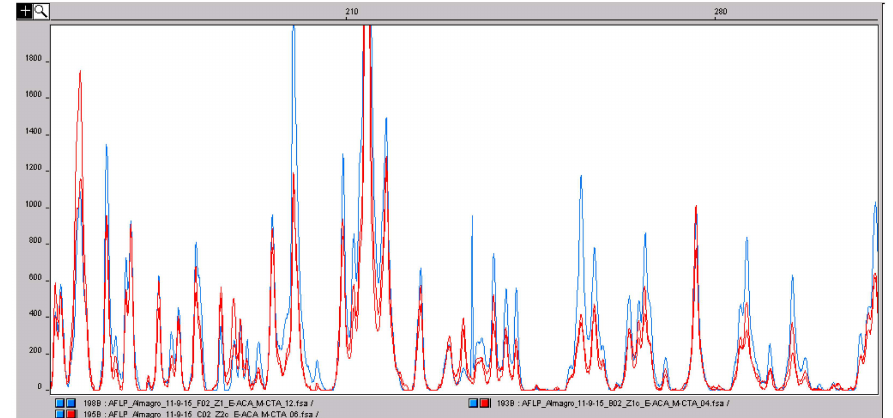
Figure 5. Comparison of the amplified fragment length polymorphism (AFLP) profile of saffron stigmas (blue) and two saffron powder samples (red). The peaks correspond to DNA fragments with a defined size in base pairs. The three profiles are almost perfectly superimposable. Usually, food processing can induce DNA degradation and, consequently, a change in the genetic profile obtained with multilocus molecular markers, such as AFLP. In this situation, the results clearly shows that the degradation of saffron DNA does not influence the AFLP genetic profile. This confirms the suitability of multilocus marker approaches to saffron